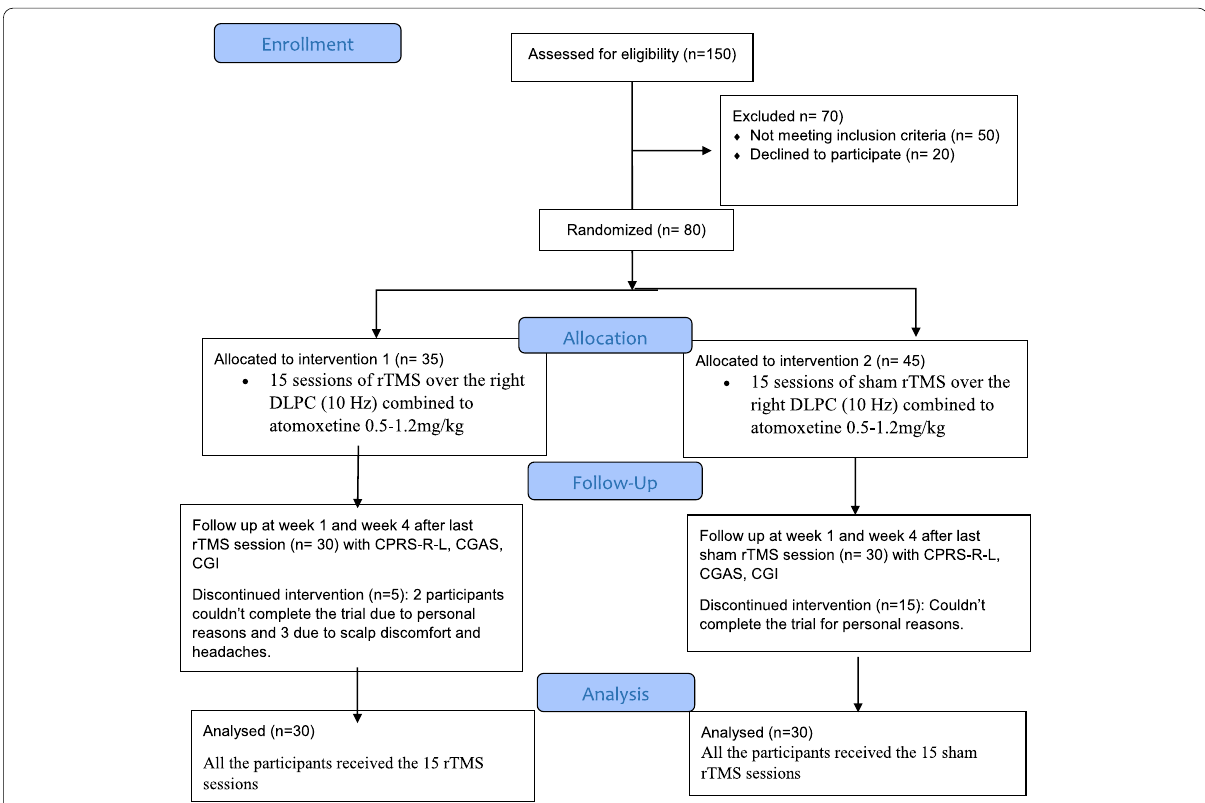
Fig. 1 A flow diagram showing how the study sample was recruited and handled during the study. Schulz KF, Altman DG, Moher D, for the CONSORT Group. CONSORT 2010 Statement: updated guidelines for reporting parallel group randomised trials. Ann Int Med 2010;152. Epub 24 March